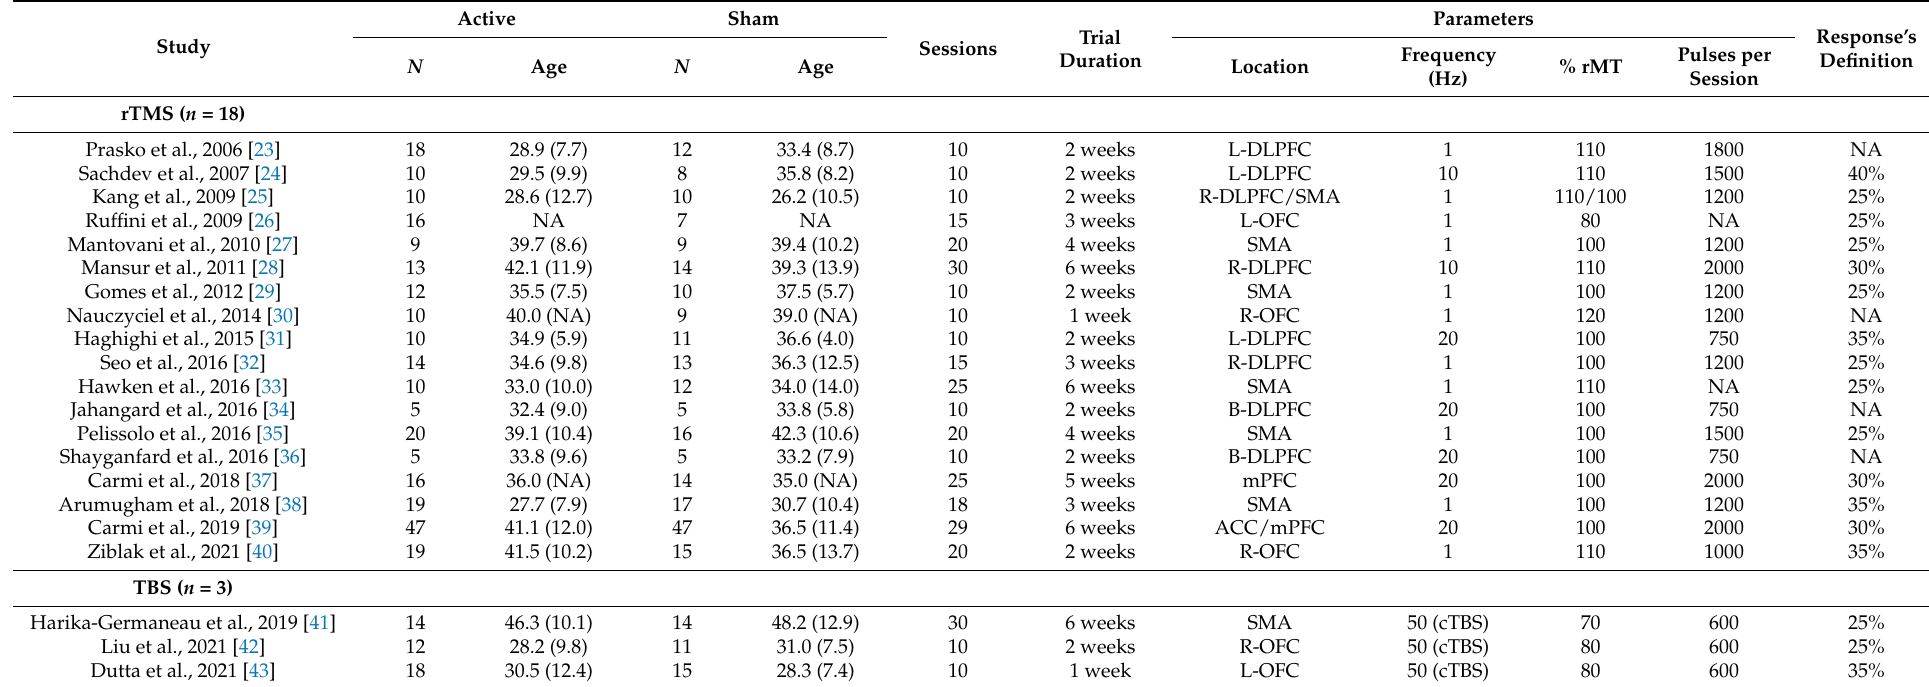
Table 1. Main characteristics of the included studies (rTMS and TBS).